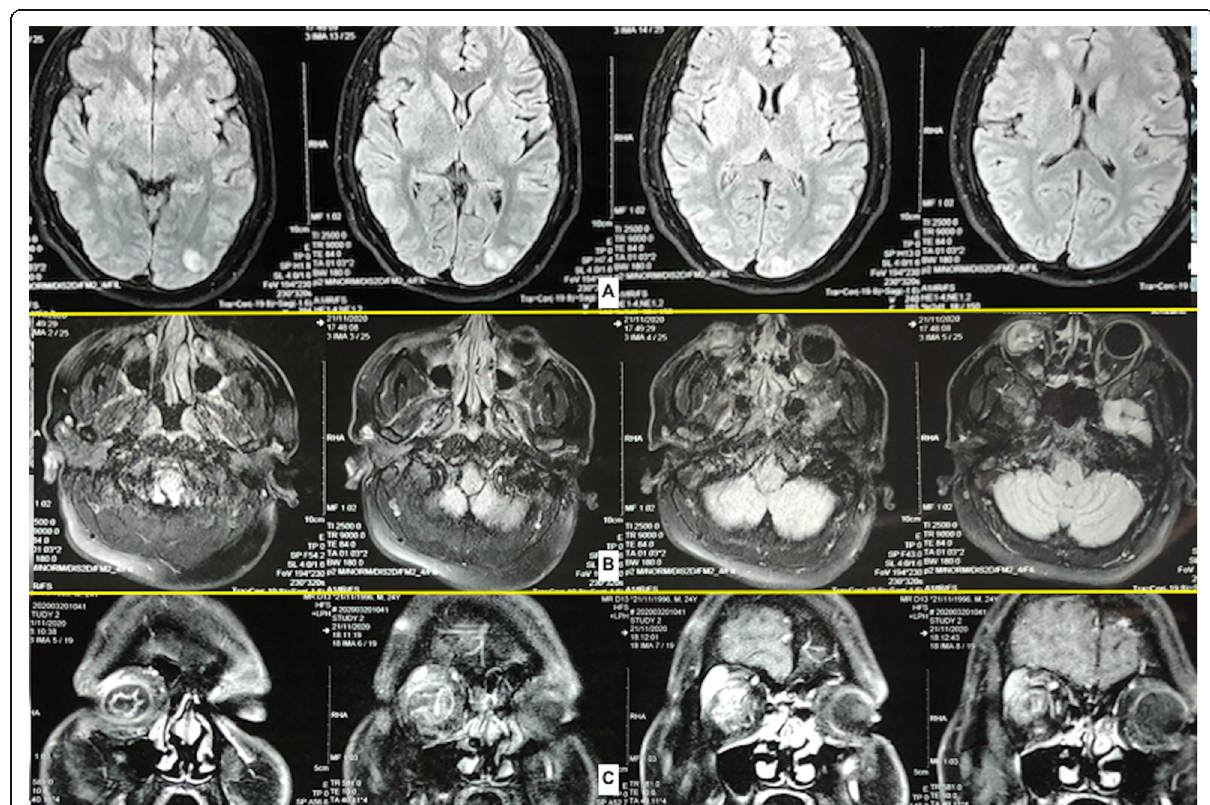
Fig. 3 Pre-operative MRI — A multiple acute embolic infarcts in the bilateral cerebral hemisphere, B sagittal section showing the right globe appears small and distorted with T2 isointense subretinal contents along with thickened retinal and choroidal layers and C coronal section showing the